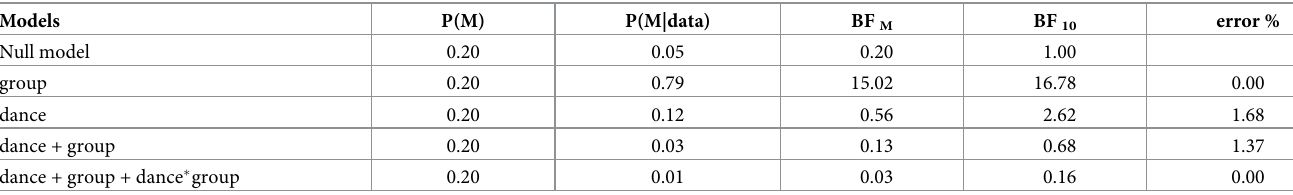
Table 9. Comparison of Bayes models: Dance &